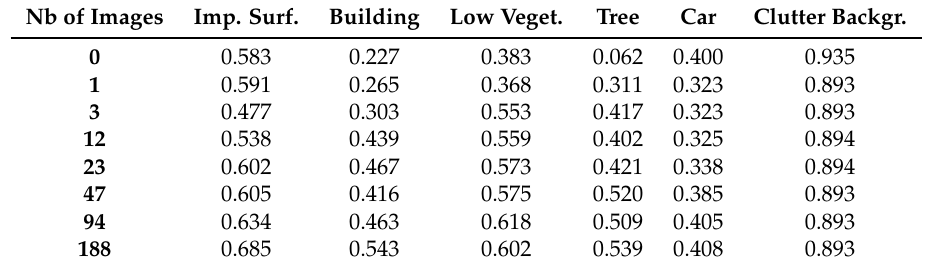
Table 6. Improvement of per-class accuracy for different numbers of sampled images from the target domain. Nb of Images